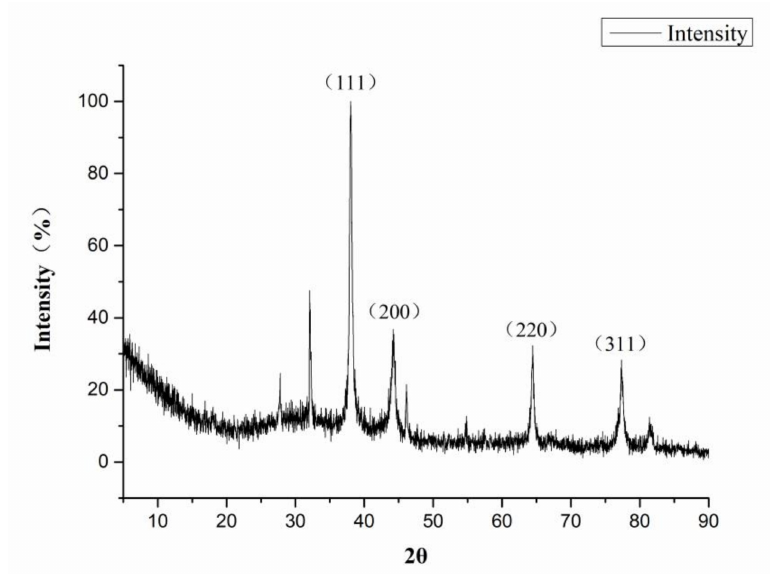
Figure 5. XRD pattern of